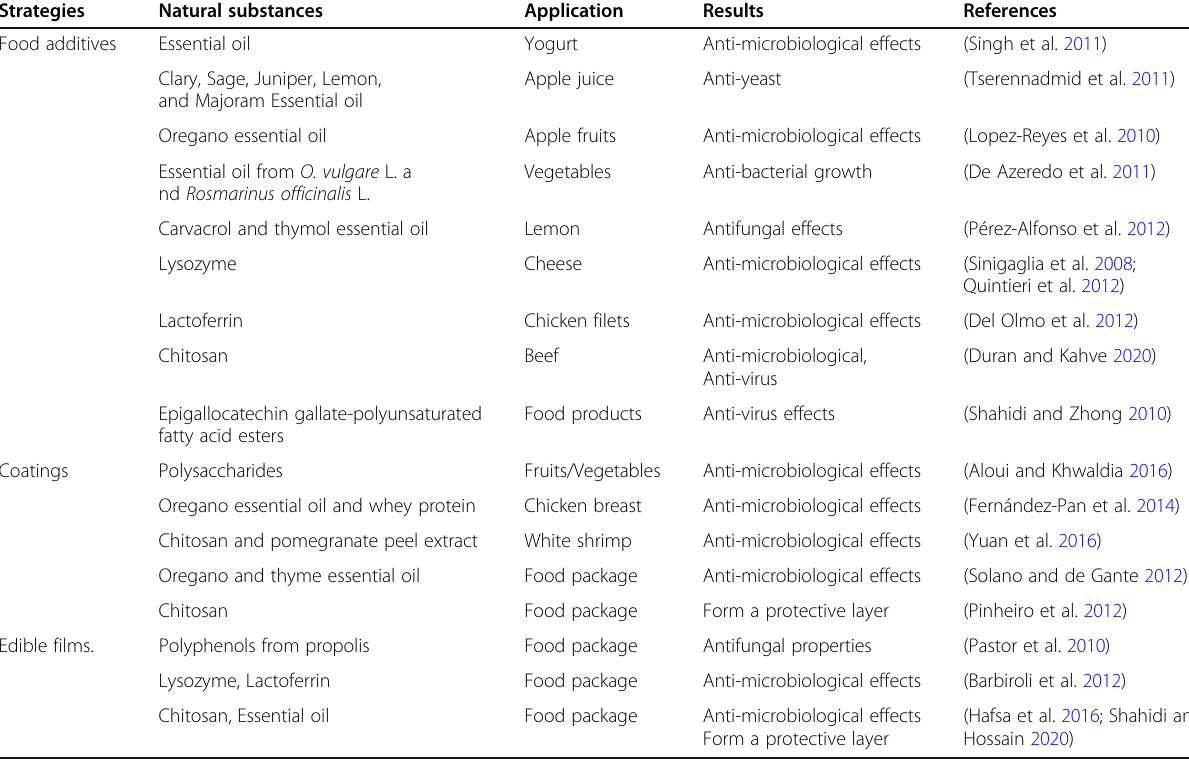
Table 2 Strategies used in the food industry to control food contaminants and food-borne virus through bioactive substances